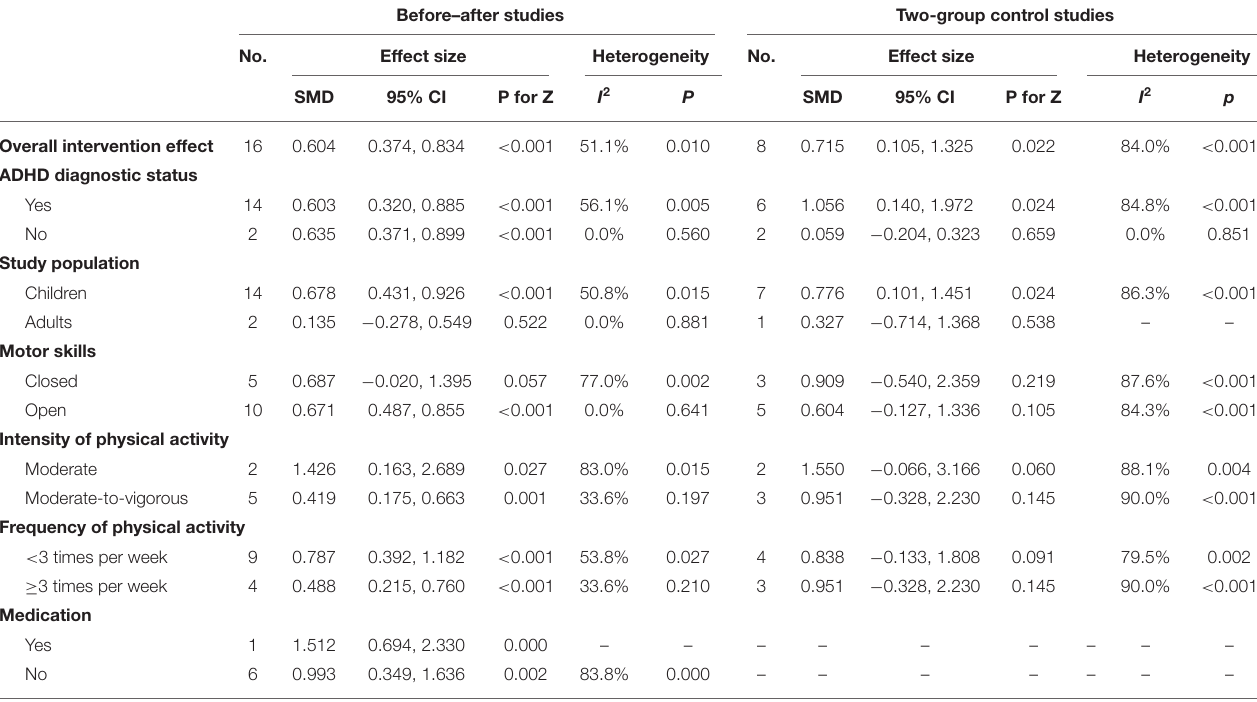
TABLE 2 | Pooled effect size for physical activity intervention on attention problems.